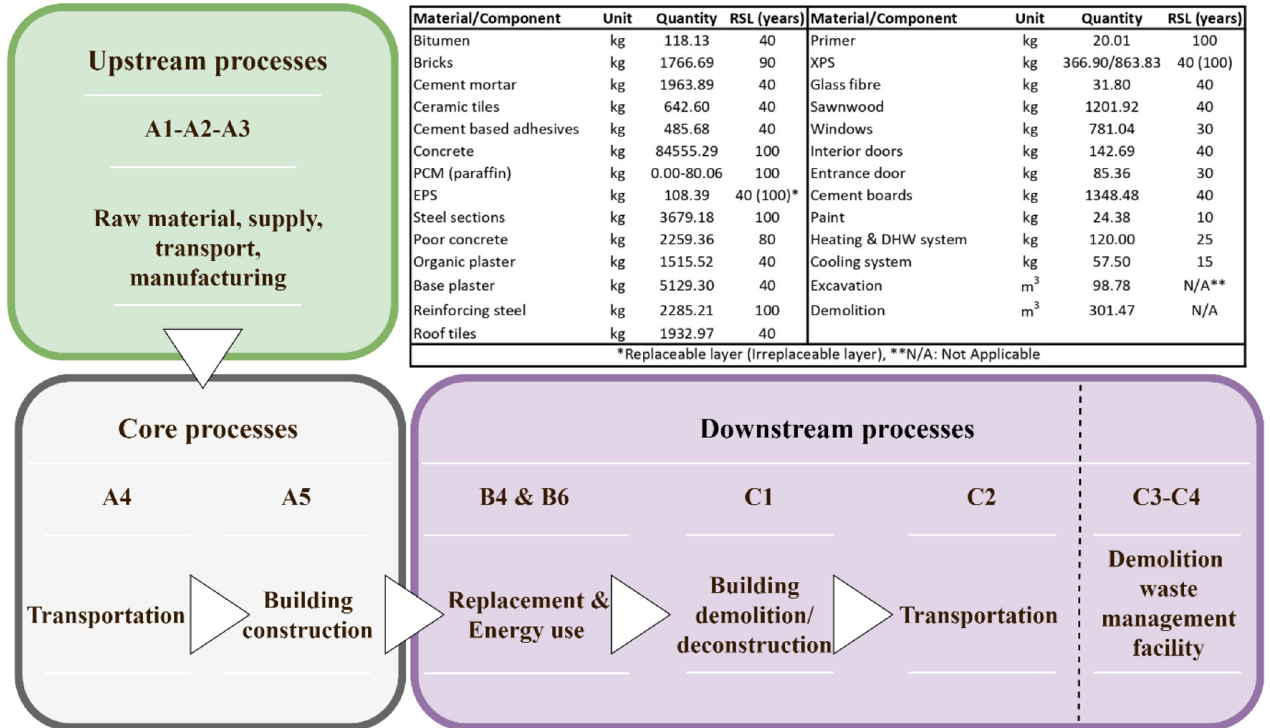
Fig. 2. System boundaries and life cycle processes for the analysed building. Bill of